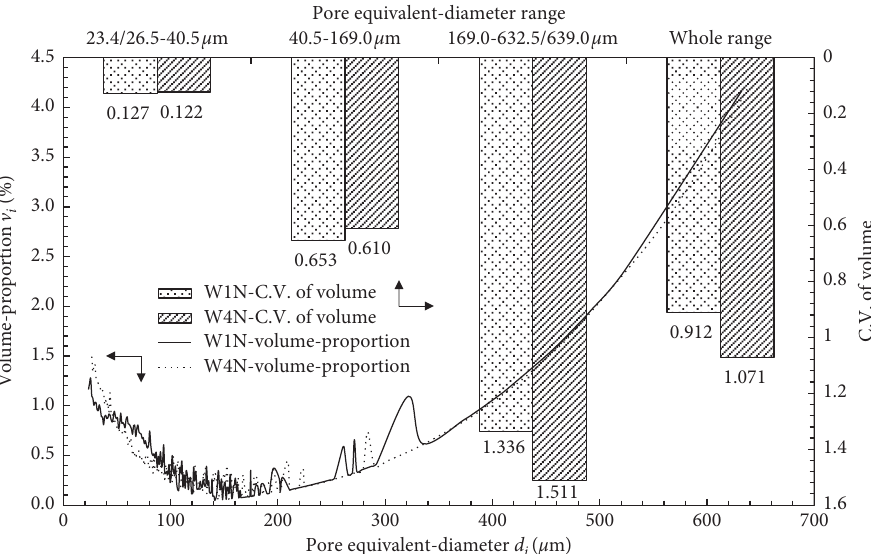
Figure 22: Volume-proportion distribution and C. V. of volume of pore-phase of NCG concretion by 3D-XRM.